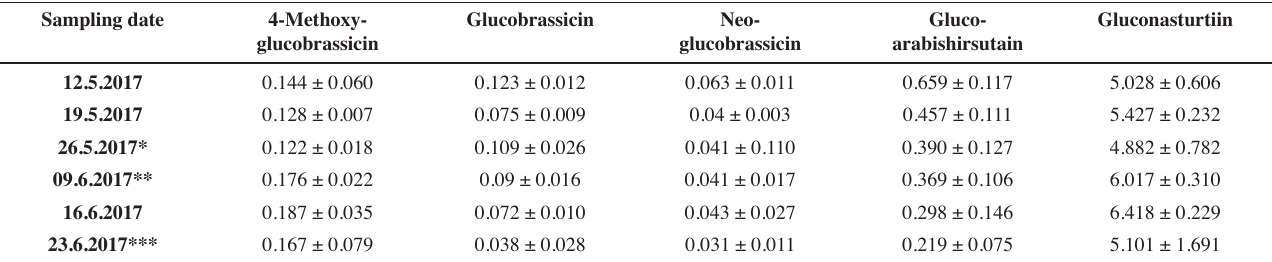
Tab. 5: Mean concentration of different glucosinolates (GLs) (μmol g DW -1 ) in watercress in above ground plant material collected at different time points. Plants were growing in an outdoor aquaponic system and harvested to analyze changes in GL contents in the course of the season and developmental stage of the plants. The standard deviation represents the values for three biological